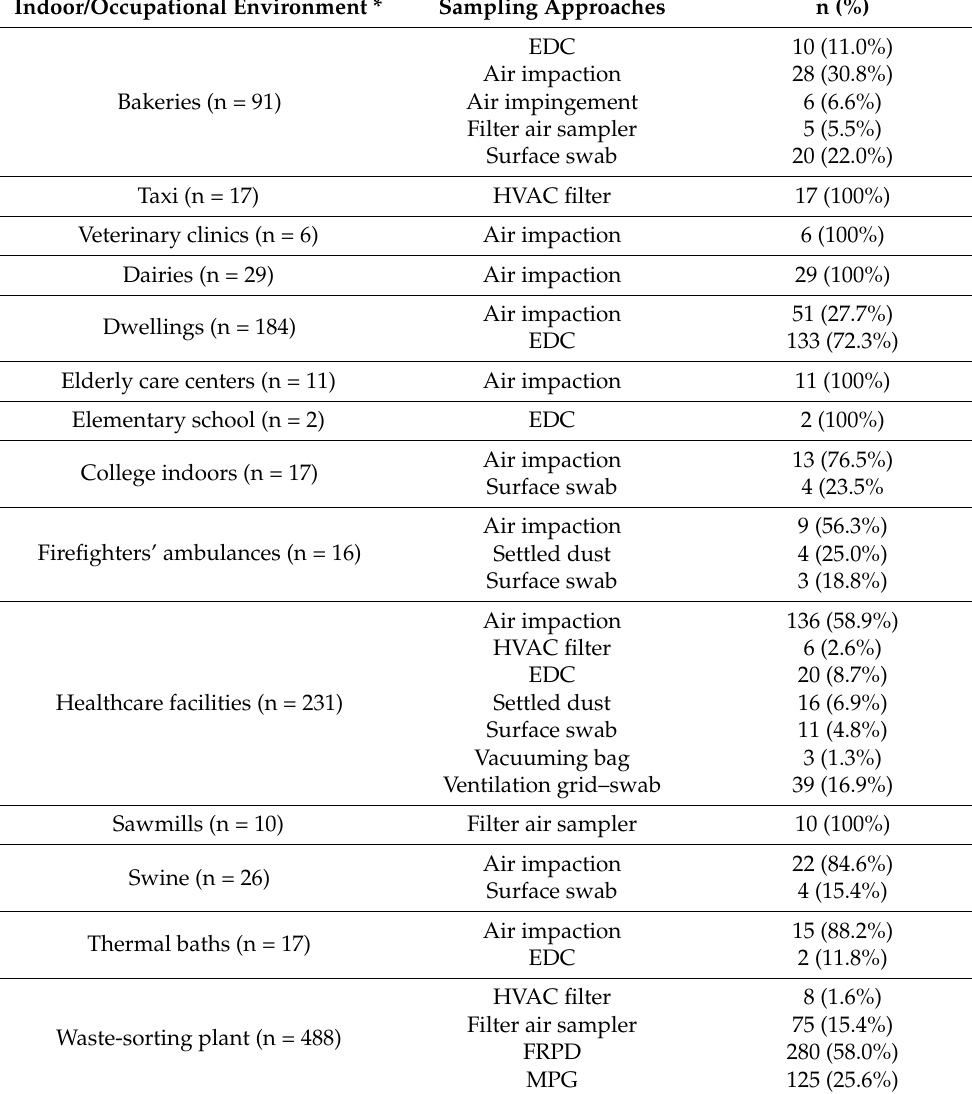
Table 1. Indoor and occupational environments assessed and applied sampling